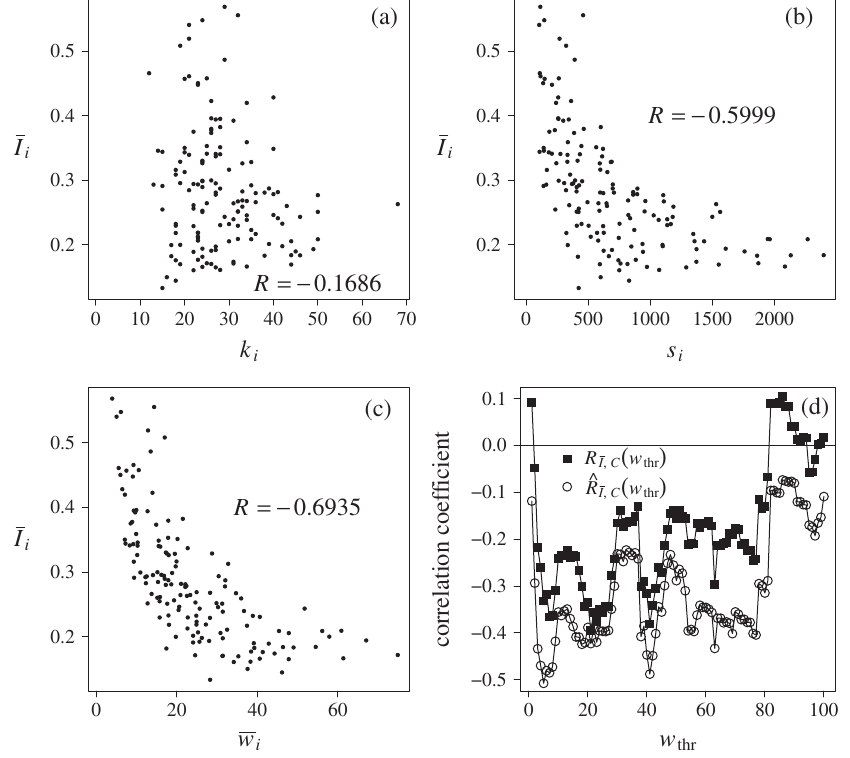
FIG. 14. Normalized mutual information (cid:1) I i is plotted against (a) degree k i , (b) node strength s i , and (c) average node weight (cid:1) w i , for D . The Pearson correlation coefficient R between the plotted quantities is also shown. (d) Pearson correlation coefficient 1 Þ (squares) and the partial correlation coefficient between these quantities with k between (cid:1) I i and C i ð w thr